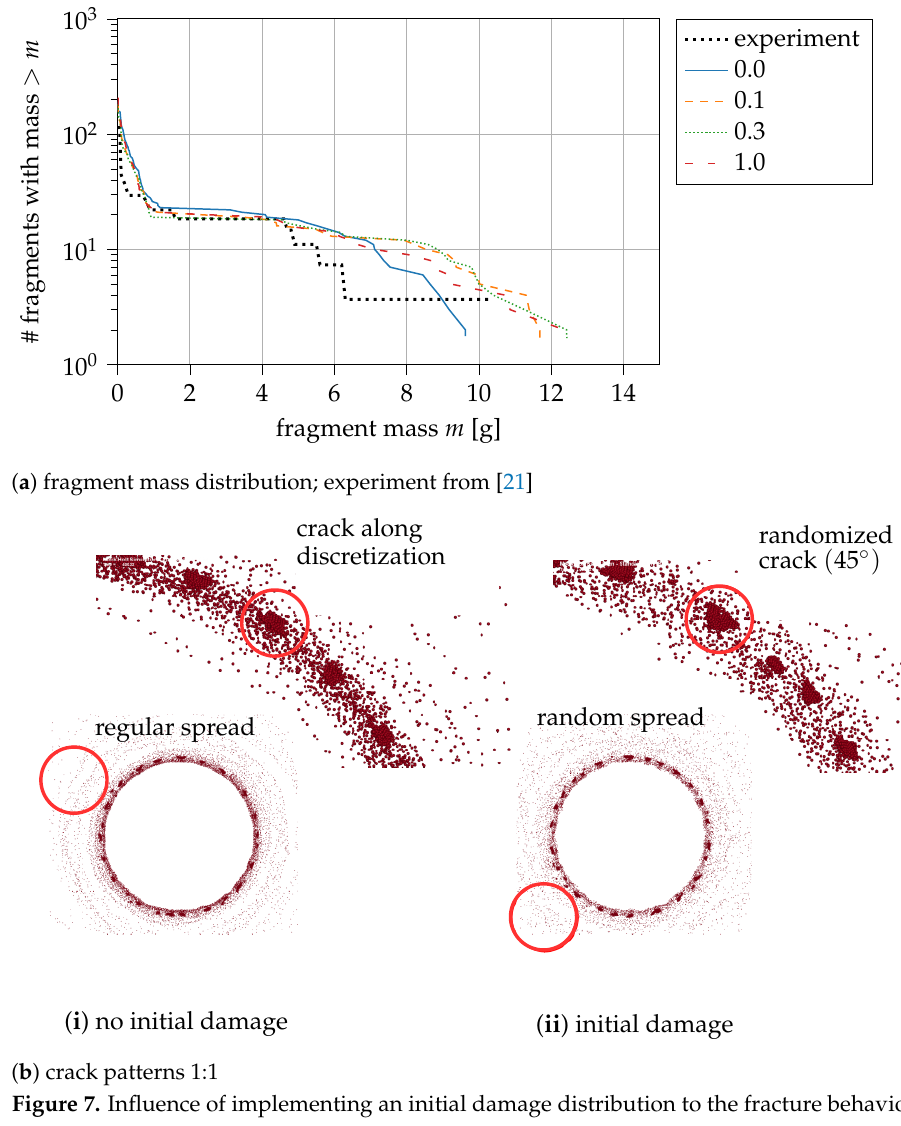
Figure 7. Influence of implementing an initial damage distribution to the fracture behaviour of the hollow cylinder ring; the label “0.0”–“1.0” is the amount of maximum damage D 0,max during the initial